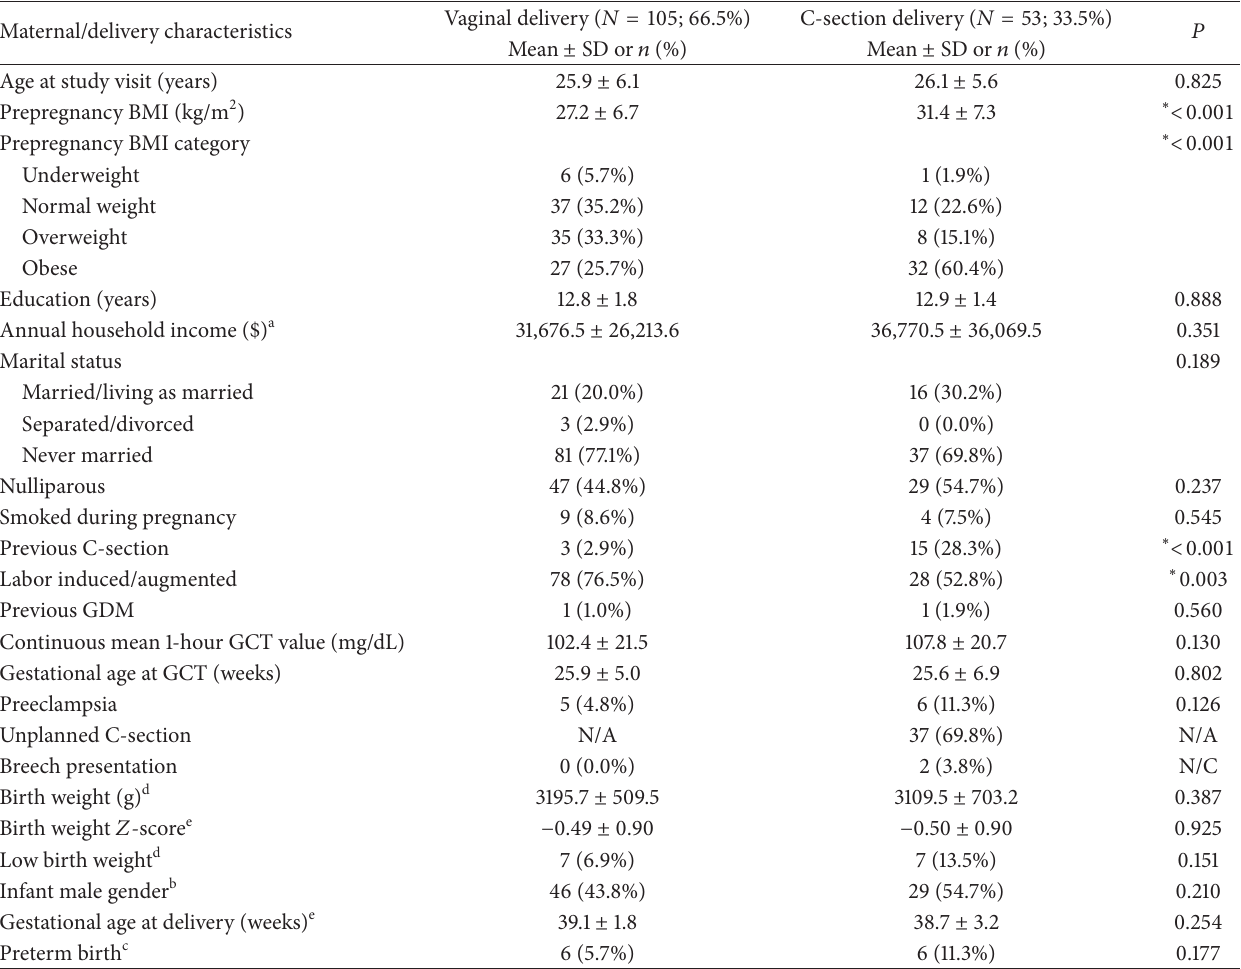
Table 1: Study participant characteristics ( 𝑁 = 158 ), by delivery